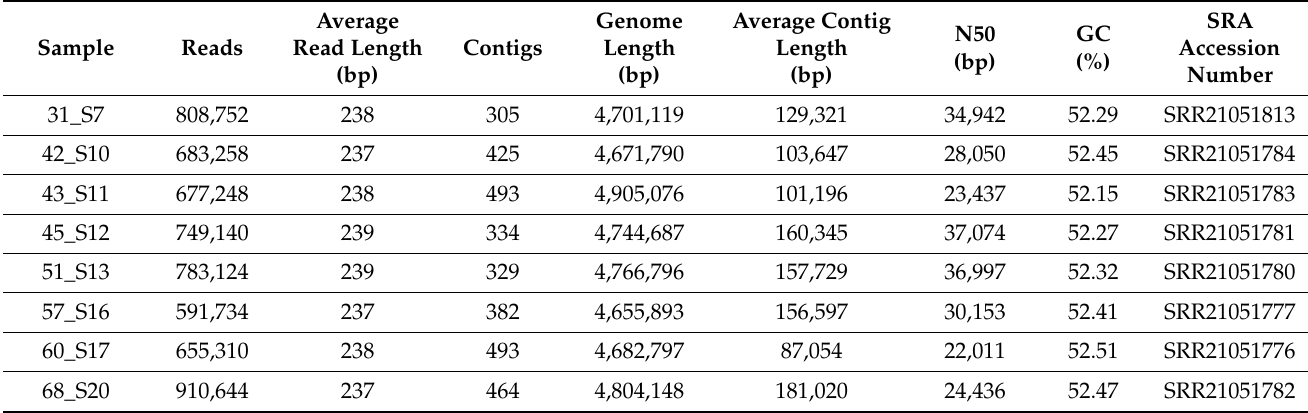
Table 2. Characteristics of sequenced and assembled genomic